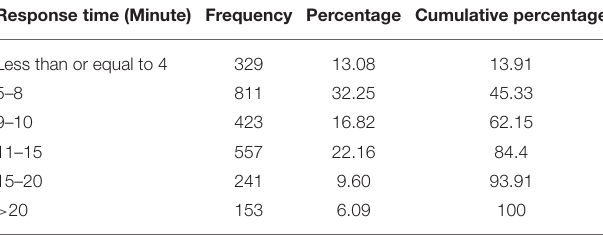
TABLE 3 | Response time of fire stations in times of fire incidents. Response time (Minute) Frequency Percentage Cumulative